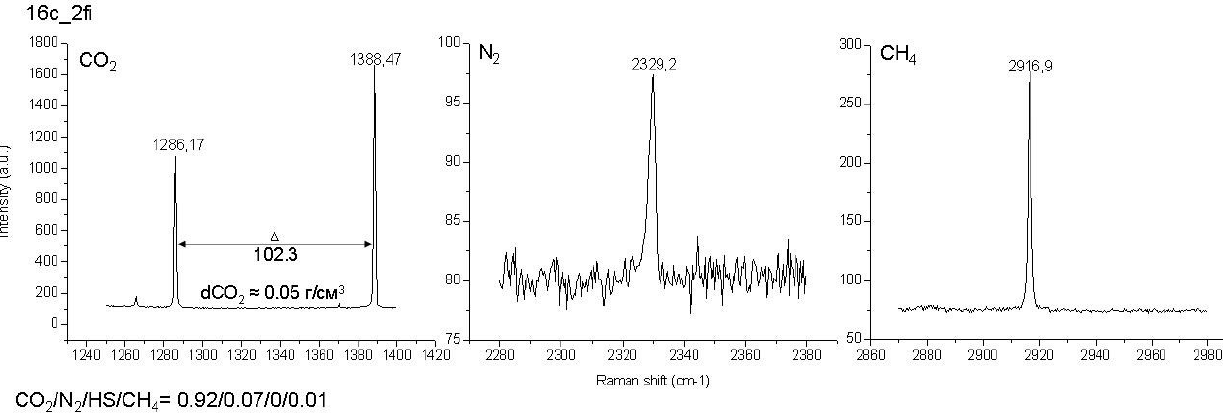
Figure 6. Raman ‐ spectra, showing the gas composition (CO 2 , N 2 , CH 4 ) of the fluid inclusion (16 с _2fi) in the Corrida ore ‐ bearing quartz. Most FI are homogenized within the temperature range of 163 to 340 ° С (Table 6). FI with predominant gas phase (FF = 50) are homogenized at 237–300 ° С (Table 6), and those